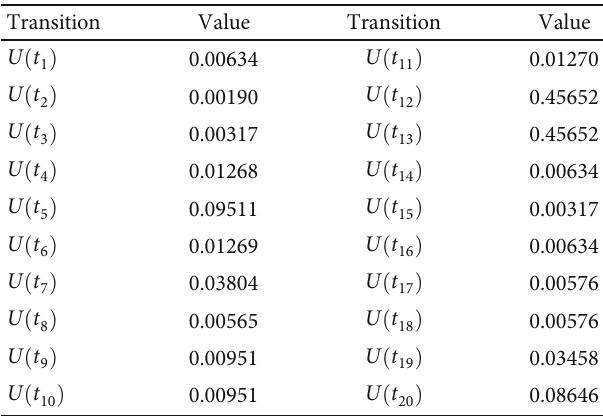
Table 4: Utilization rate of